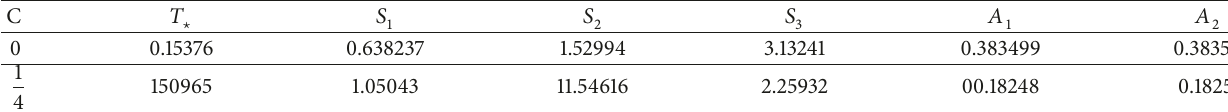
Table 2: Check of the equal area law in the 𝑇 − 𝑆 plane for different 𝐶